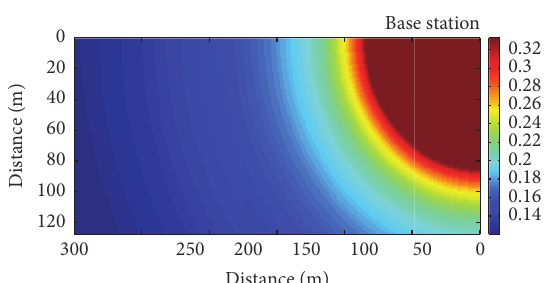
Figure 12: CR architecture with infrastructure.